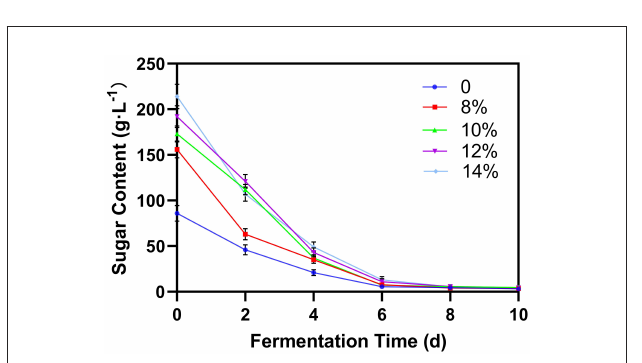
FIGURE3 Effect of additional sucrose on sugar content during main fermentation.